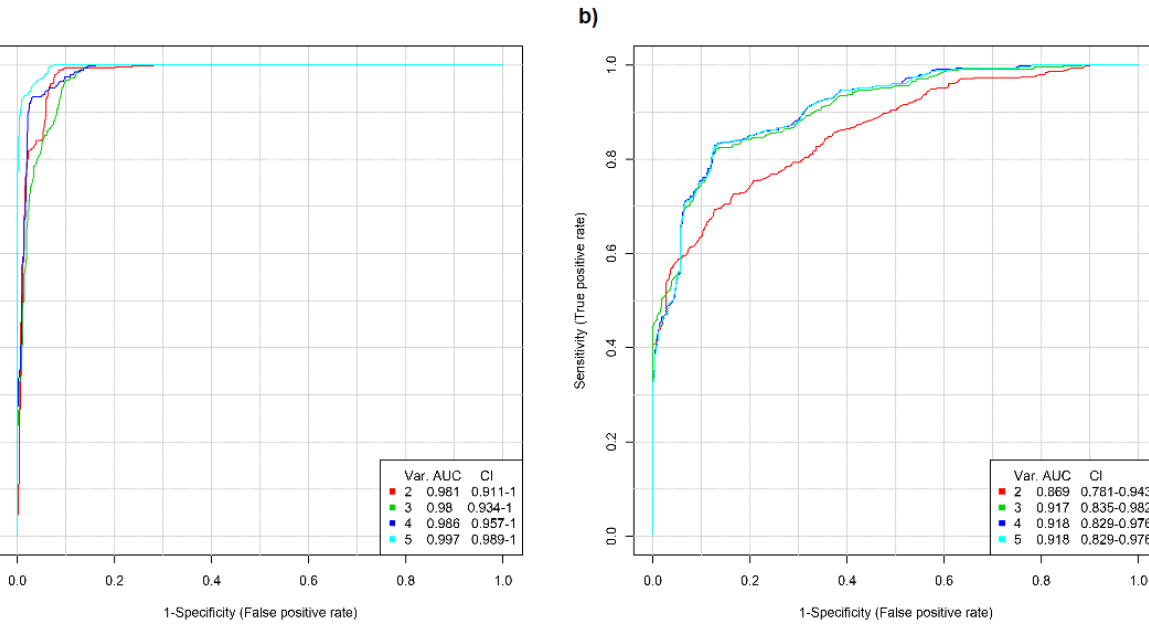
Figure 7. Multivariate ROC curves obtained by comparing the glycomic profile of the ( a ) breast cancer and ( b ) lung cancer patients to the glycomic profile of healthy subjects.